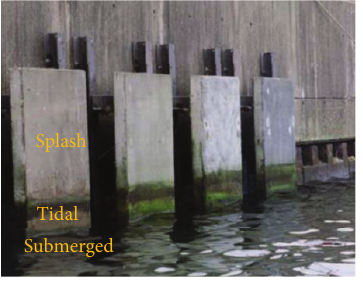
Figure 9: Exposed slabs on the Baltic Sea